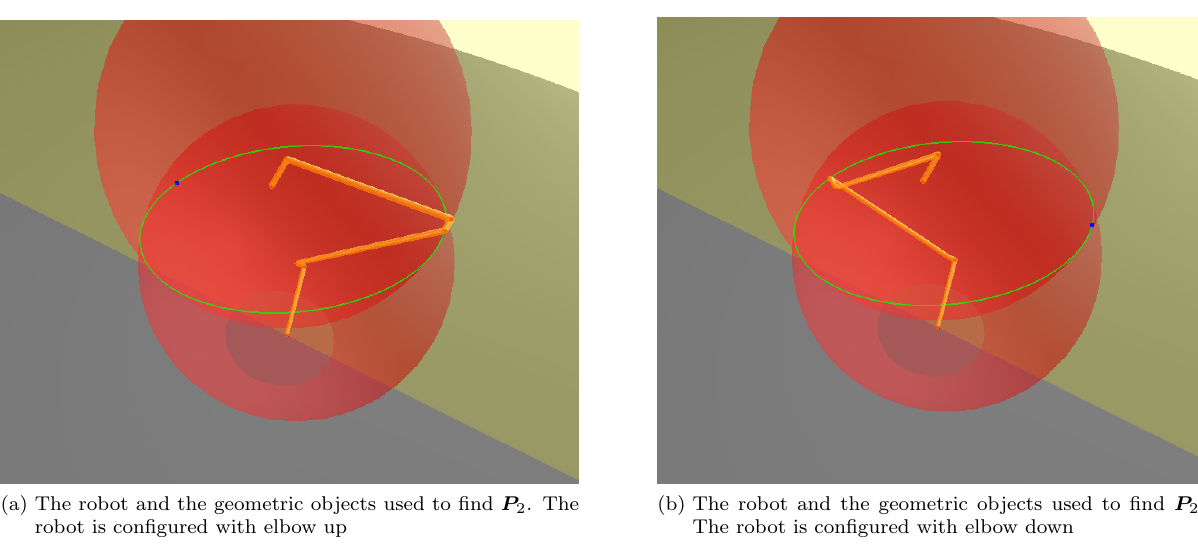
Figure 4: The red spheres are S 1 and S w , the yellow plane is Π 1 x , the green circle is generated from C 2 , and the blue point pair is Q 2 , where one is picked to be P 2 .